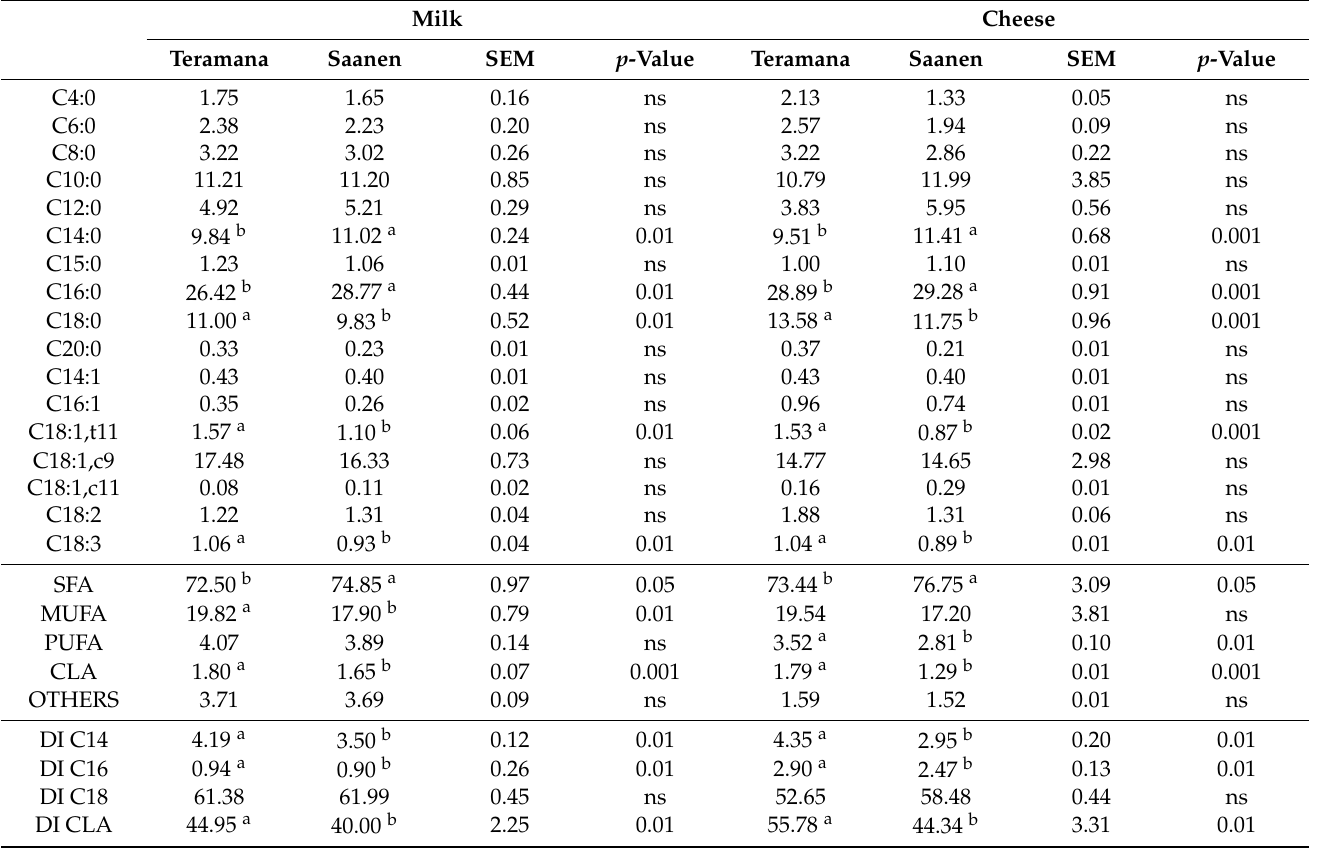
Table 1. Fatty acid composition of milk and fresh cheese (T0) obtained from two goat breeds: Teramana and Saanen. Milk